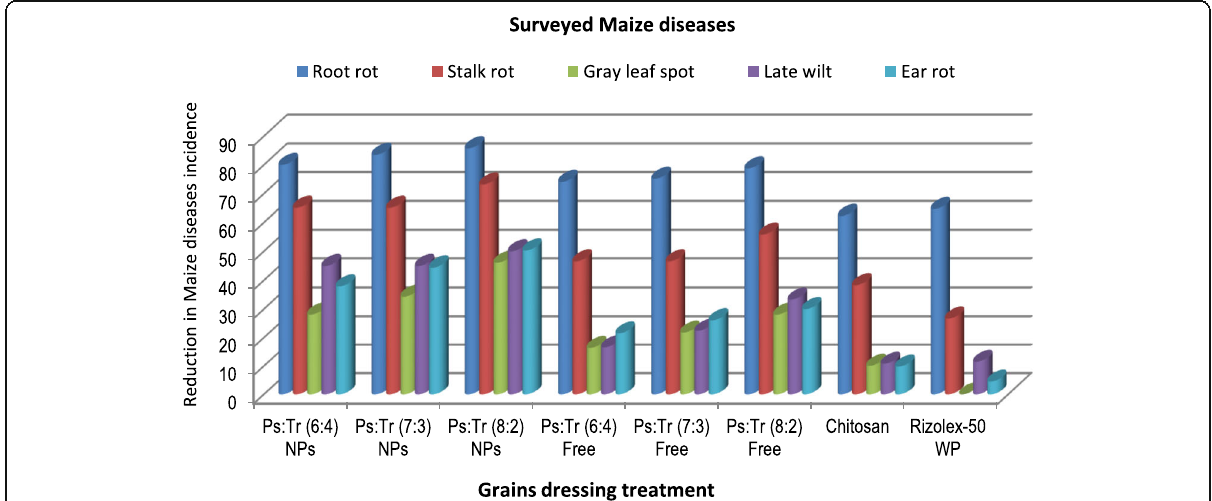
Fig. 4 Reduction in Maize diseases in response to using fermented maize wastes as grain dressing under field